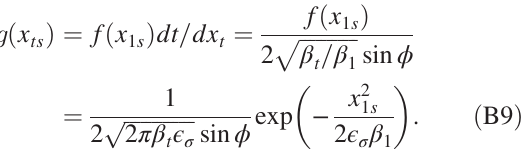
TABLE III. Relationship between relative intensity at edge to center ( F ), phase advance ϕ of obtained using Eq. (B13), K (cid:1) 8 obtained using Eqs. (A13) and (16), and the maximum beam loss for the aperture having (cid:5) 3 σ of the linear optics at cot φ ¼ − 0 . 5 . F ϕ [deg] cot ϕ K (cid:1) 8 Beam loss